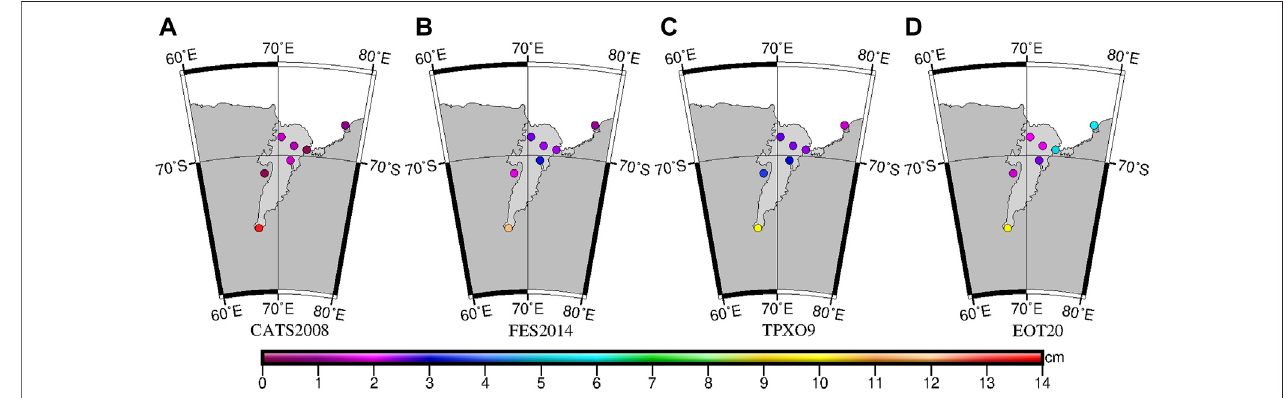
FIGURE 8 | RSS of each station in the AIS of (A) CATS2008, (B) FES2014, (C) TPXO9, and (D) EOT20.